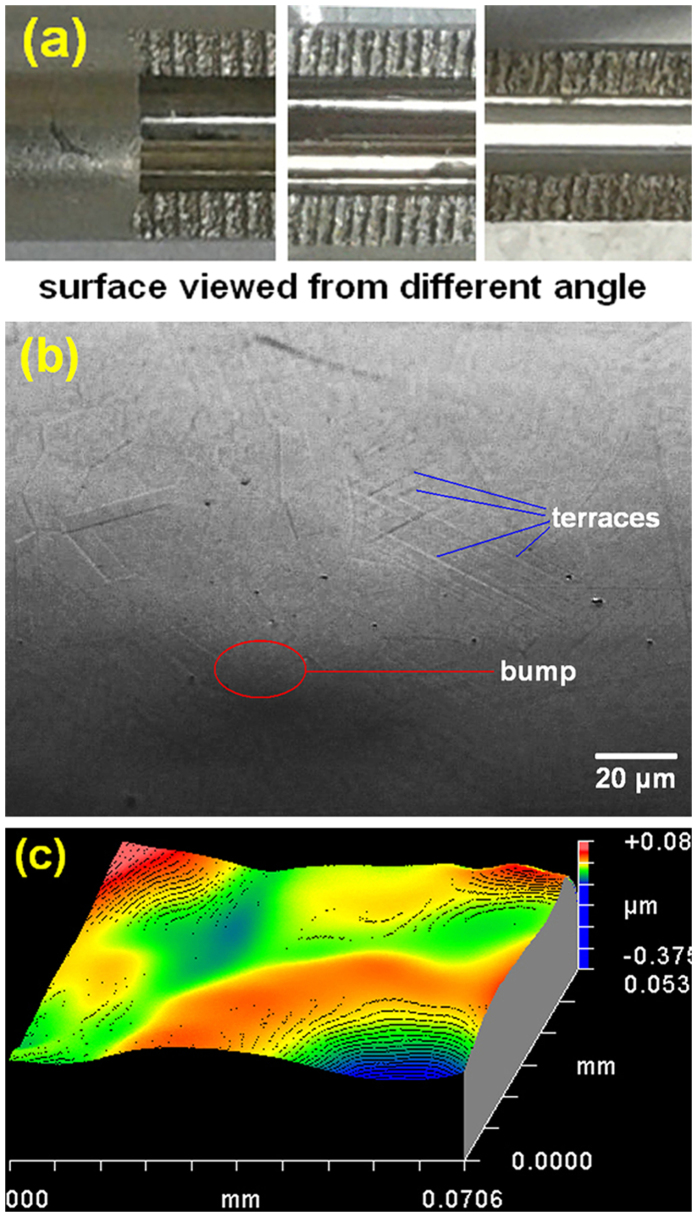
(a) The optical image, (b) microscopy image and (c) optical surface profiler image of inner surface of a cut MWC.